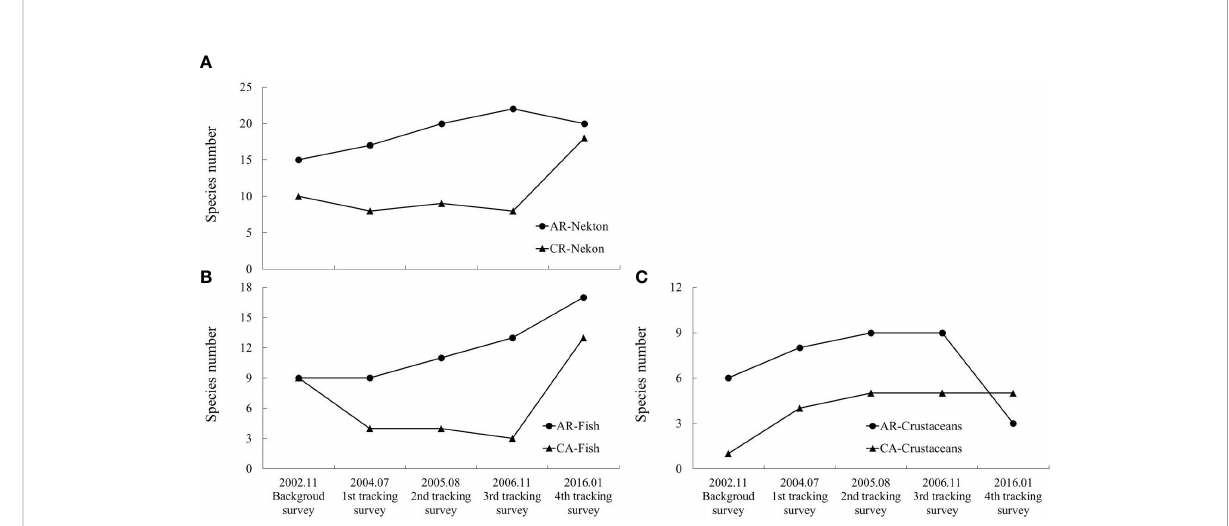
FIGURE 5 Species composition of nekton (A) , fi sh (B) and crustaceans (C) collected during each gill net sampling periods in AR and CA habitats.